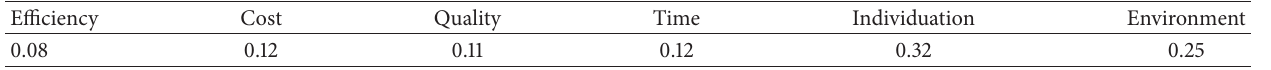
Table 8: The final weight of functional objectives on manufacturing system.